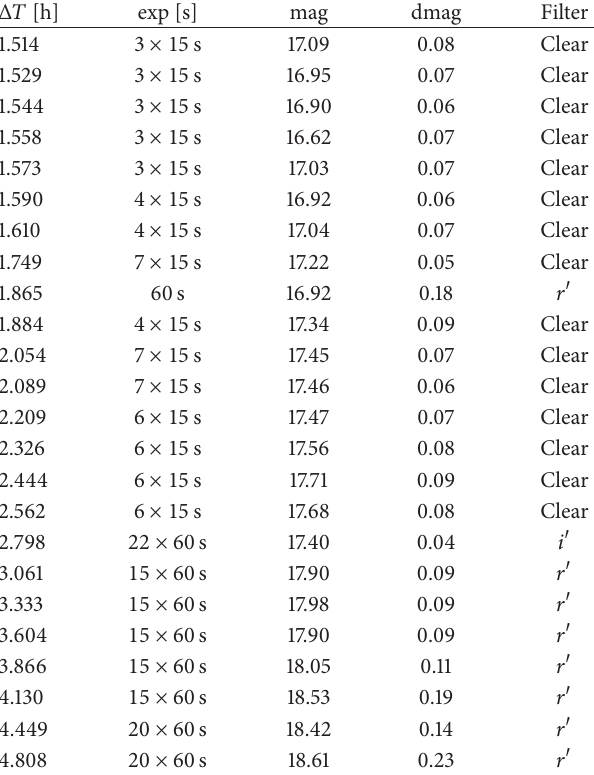
Table 15: GRB 130418A: observing log of BOOTES-1B and BOOTES-2.